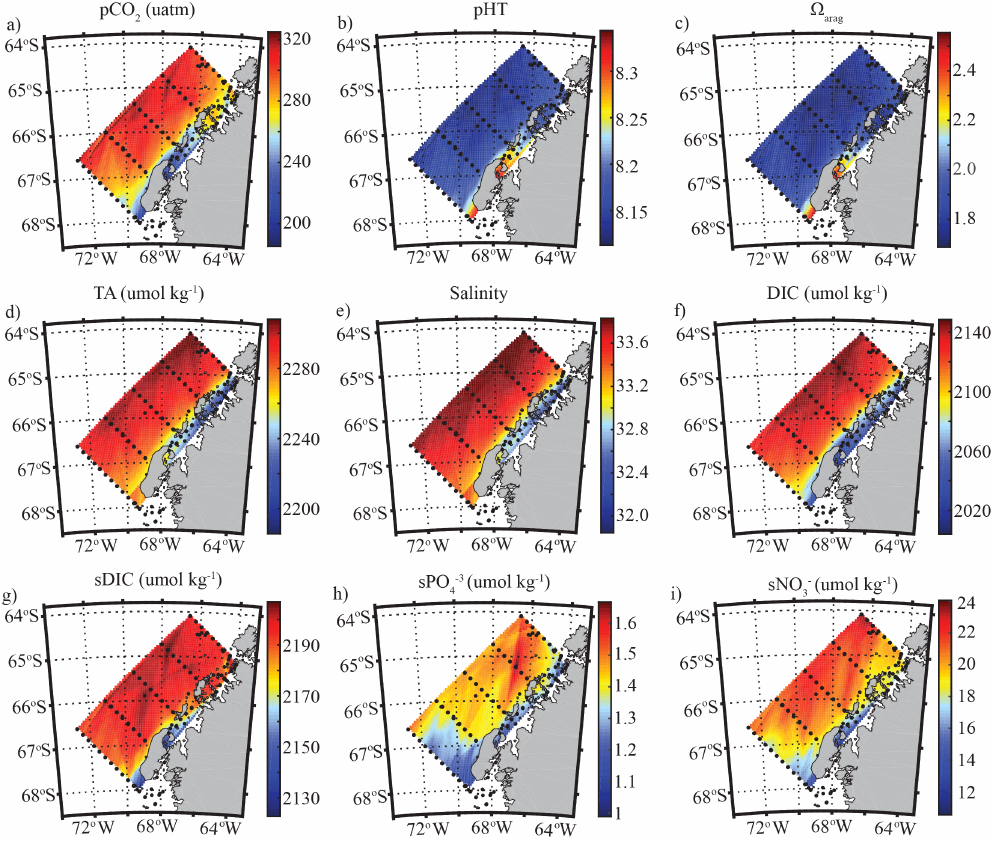
Figure 4. Maps of summertime averages of surface (a) p CO 2 , (b) pHT, (c) aragonite saturation state ( (cid:127) arag ) , (d) total alkalinity (TA, µmolkg − 1 ) , (e) salinity, (f) dissolved inorganic carbon (DIC, µmolkg − 1 ) , and (g) salinity-normalized DIC (sDIC, µmolkg − 1 ) across years with available DIC and TA measurements (1993–1999, 2001–2002, and 2005–2012). Salinity-normalized PO 3 − salinity-normalized NO − (sNO − ,µmolkg − 1 ) were averaged across 1993–1996, 1999, and 2001–2012. Averages are only shown for regions 3 3 where samples were taken in five or more years. Occupied stations are shown by black